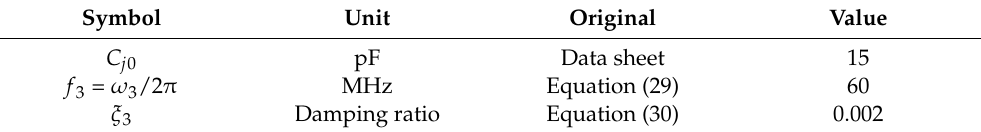
Table 5. Calculation of the Inductor charging with parameters provided in Tables 1–3.